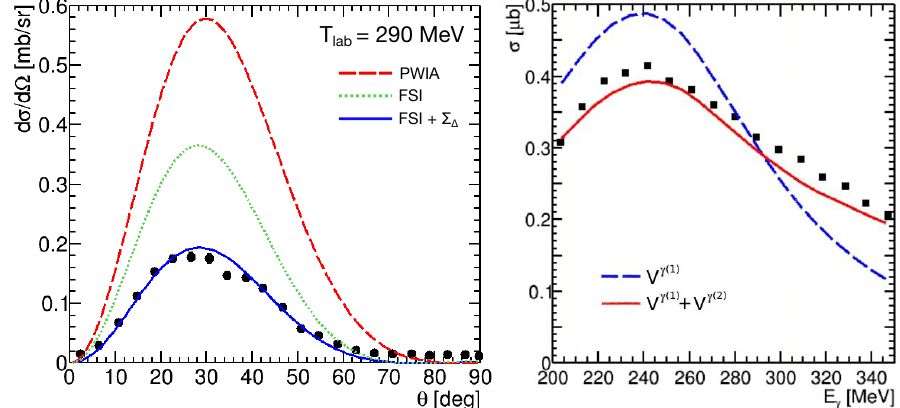
Figure 3. Predicted cross sections for pion photoproduction on 12 C. Left panel : The di ff erential cross section at photon lab energy 290 MeV. The dashed red curve represents the plain wave impulse ap- proximation, i.e., no medium e ff ects ( Σ ∆ = 0) and no final state interaction (FSI) ( F γ ( k 0 , k ′ , k λ ) = V γ ( k 0 , k ′ , k λ )) included; the dotted green curve demonstrates the e ff ect of the FSI, i.e., Eq. (17) is calcu- lated with Σ ∆ = 0; the solid blue curve is obtained with the FSI and Σ ∆ = 11 . 3 − 27 . 5 i MeV. Right panel: Energy dependence of the total cross section. The dashed blue and solid red curves are calculated with the first-order, Eq. (19), and the second-order, Eq. (21), photoproduction potentials,